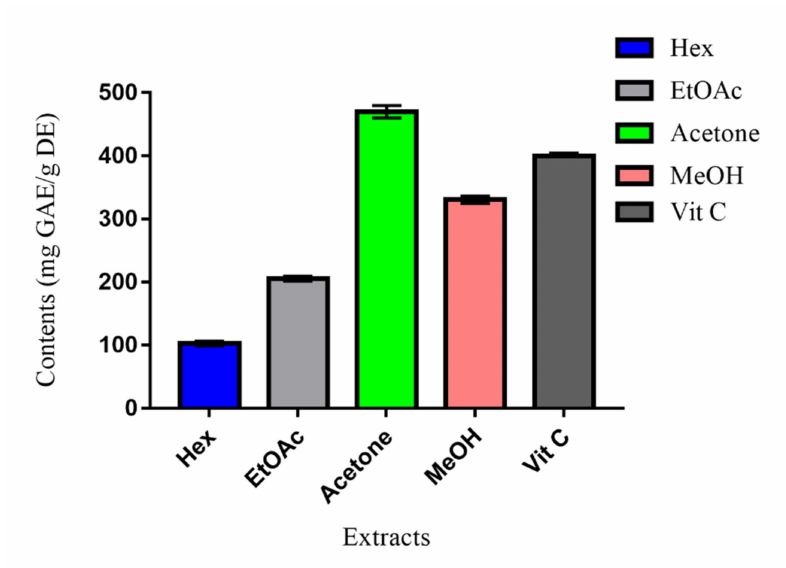
Figure 2. Total antioxidant capacity (TAC) of Erodium arborescens aerial part extracts and Vit C.